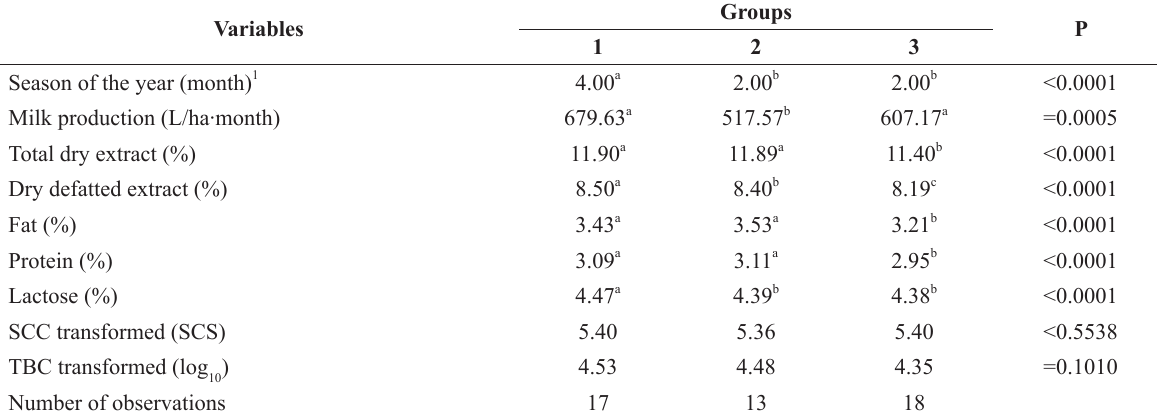
Comparison of medians using Kruskal-Wallis test for the groups formed according to the production and composition of the milk for the seasons of the year, microbiological quality of the milk, and the health of the mammary gland. Variables